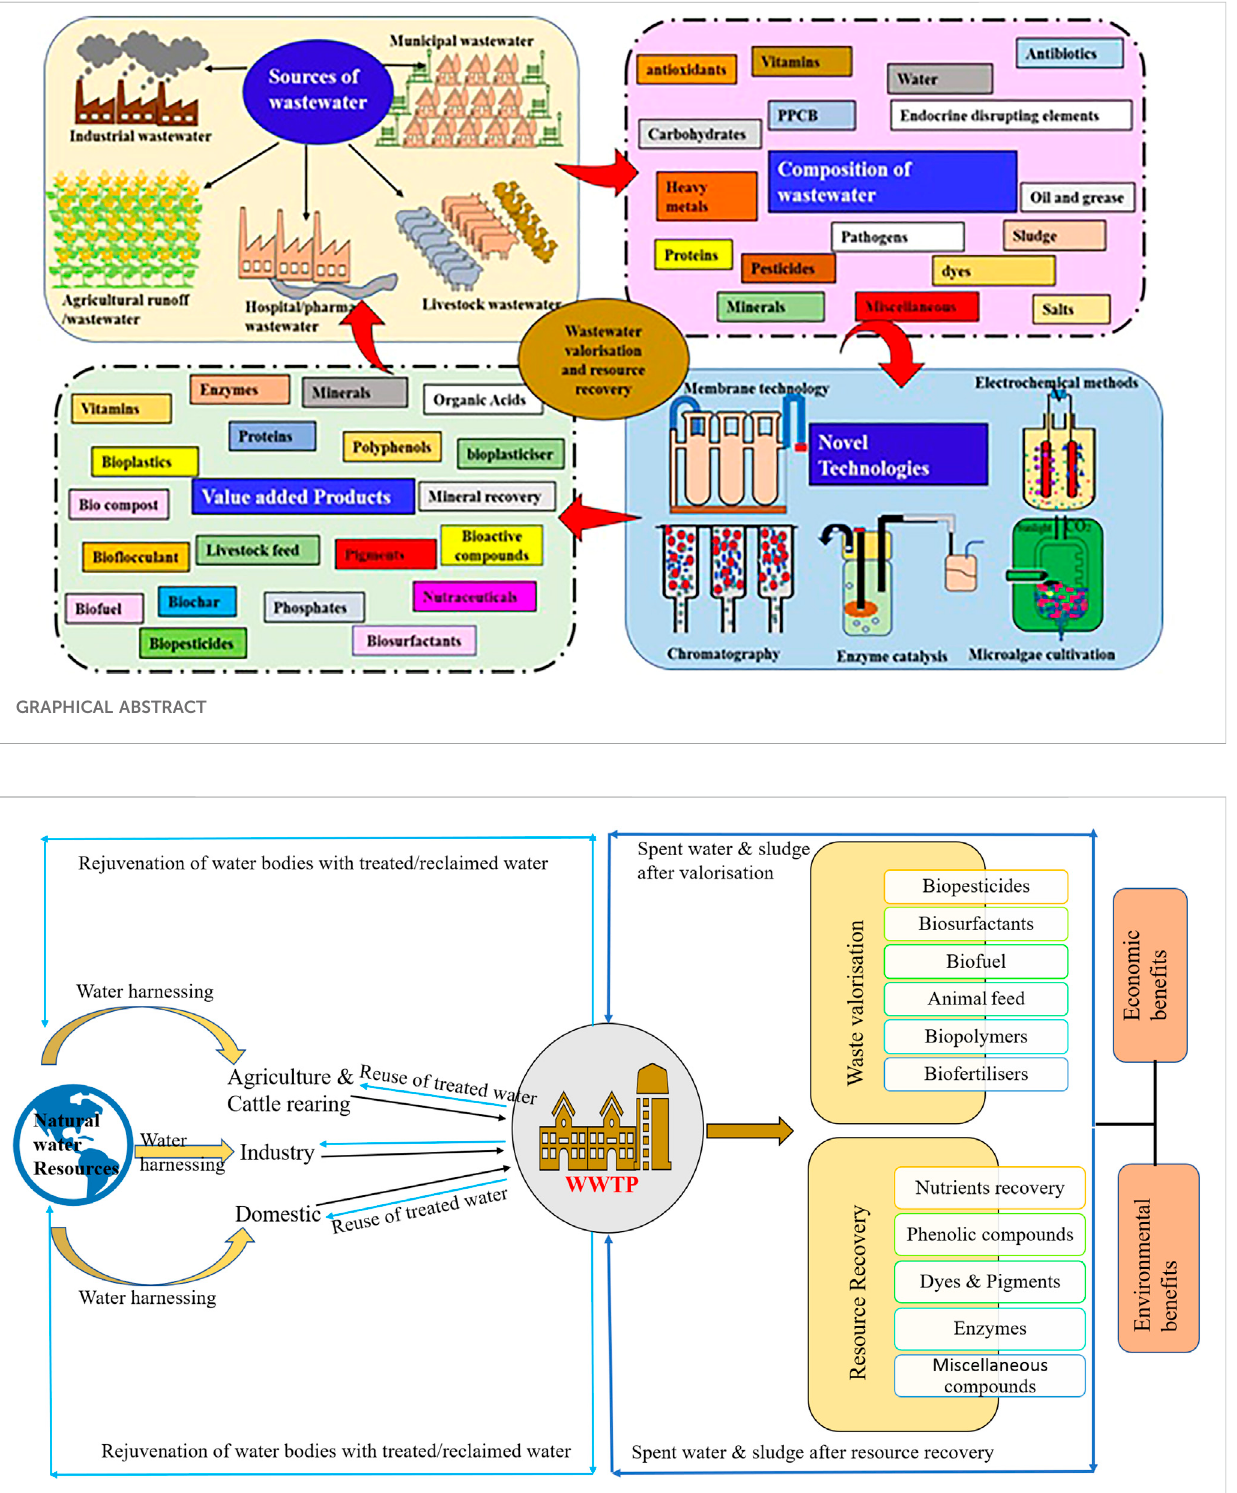
FIGURE 1 The circular economy concept of waste valorisation and resource recovery from wastewater and sludge. Adapted from Singh et al., 2022, with permission from